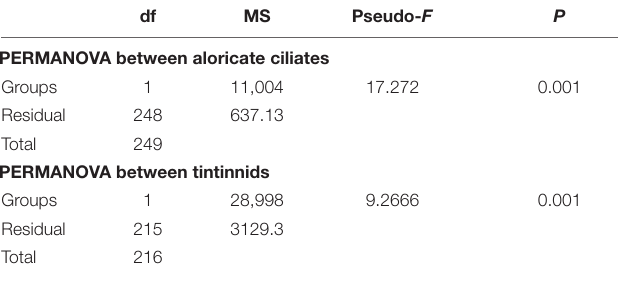
TABLE 2 | Results of PERMANOVA based on Bray Curtis similarity matrices derived from Square root-transformed abundance data of aloricate ciliates and tintinnids between 2016 and